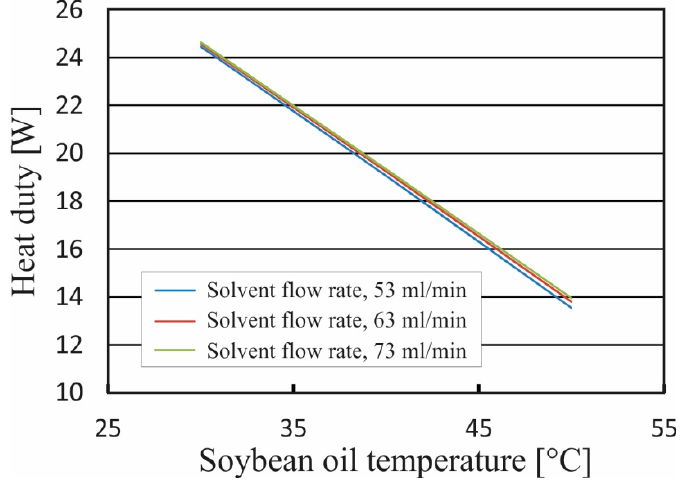
Figure 11. Heat duty of the heat exchanger.